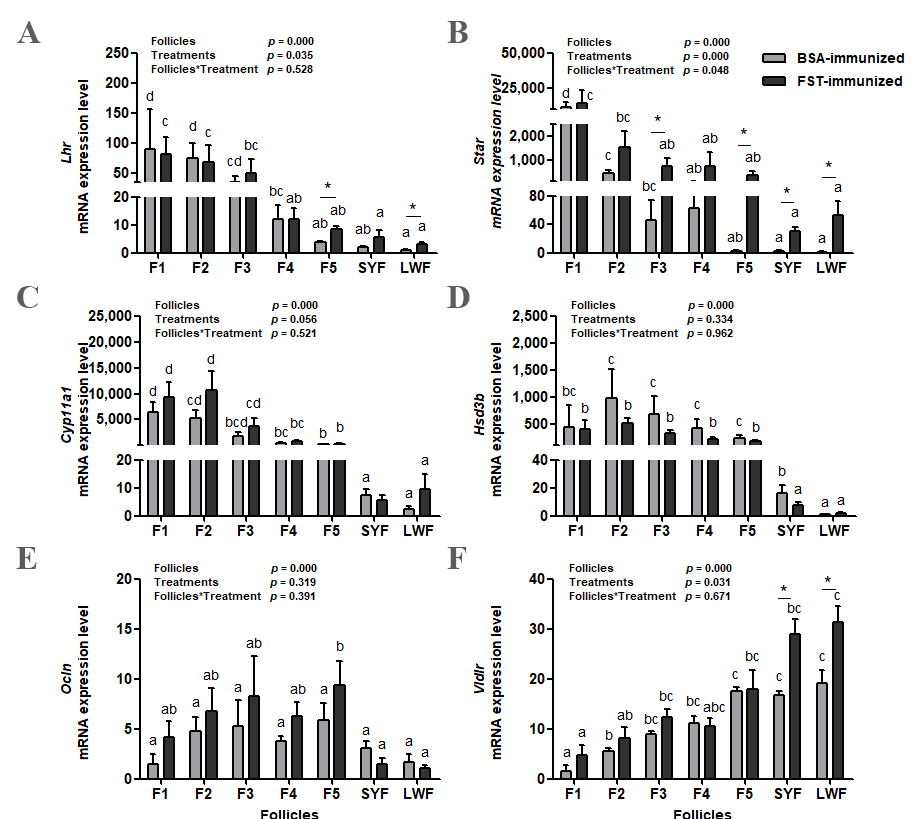
Figure 5. Lhr ( A ), Star ( B ), Cyp11a1 ( C ), Hsd3b ( D ), Ocln ( E ), and Vldlr ( F ) mRNA levels in granulosa layers from ovarian pre-hierarchical follicles (SYFs and LWFs) and pre-ovulatory follicles (F1 to F5) in FST-immunized or BSA-immunized control geese ( n = 6). For each group, a, b, c, d represents a significant difference among the means ( p < 0.05). * represents a significant difference between the two groups in one type of follicle ( p < 0.05). Data represent mean ± SEM.